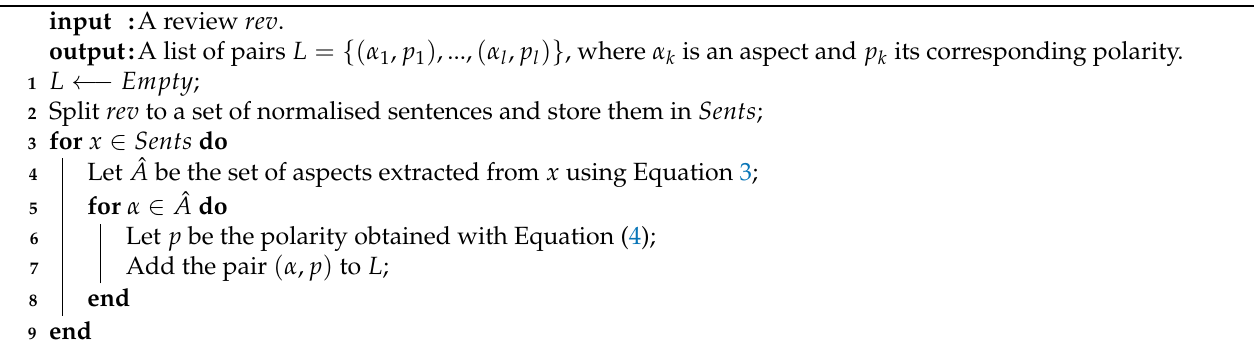
Algorithm 1: Aspect extraction and polarity detection